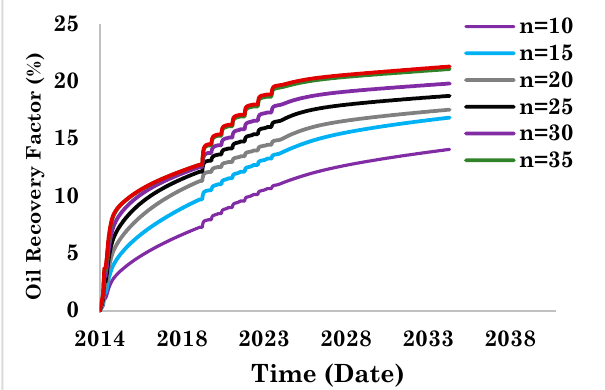
Figure 13. CO 2 Injection (Extended Cycle Size) 38 API Oil.